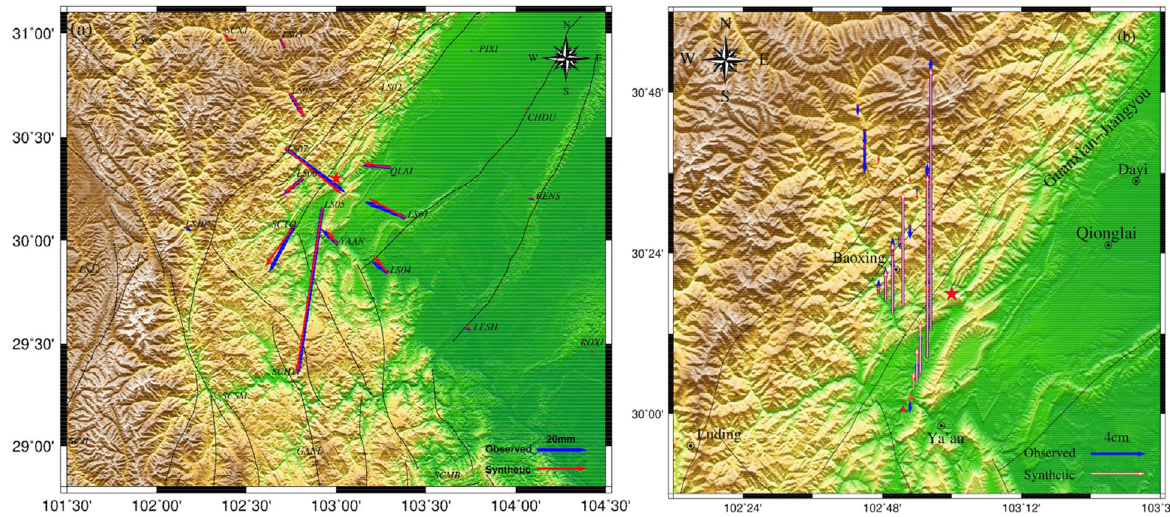
Figure 6. ( a ) The blue vector “Observed” represents the GPS observation, the red vector “Synthetic” represents simulated GPS data based on the finite fault model (triangular curved fault). ( b ) The blue vector “Observed” represents the vertical displacement observed by the leveling station, the red straight line “Synthetic” represents simulated Leveling data based on the finite fault model (triangular curved